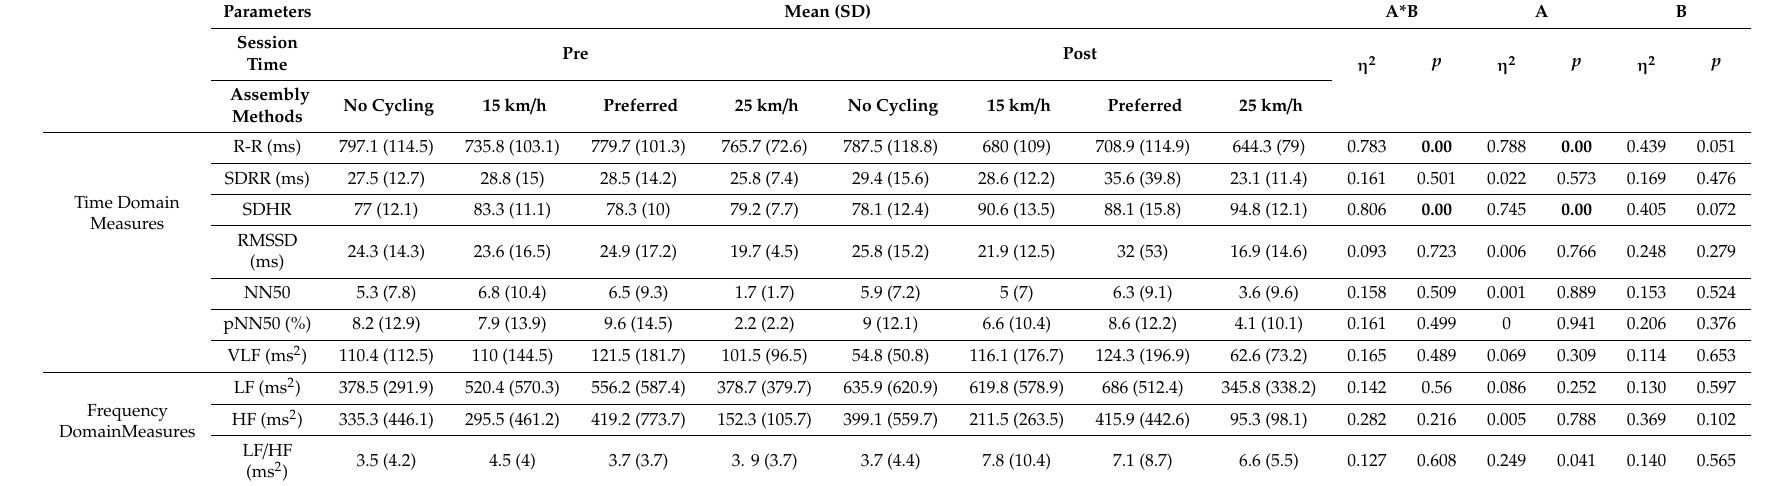
Table 4. Mean (standard deviation) values of heart rate variability before and after assembly tasks with cycling